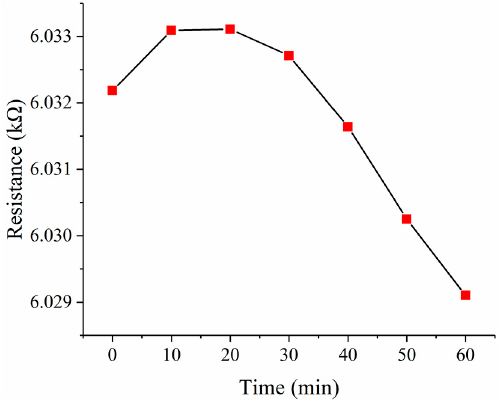
Figure 16. The fluctuation of the resistance in one hour.